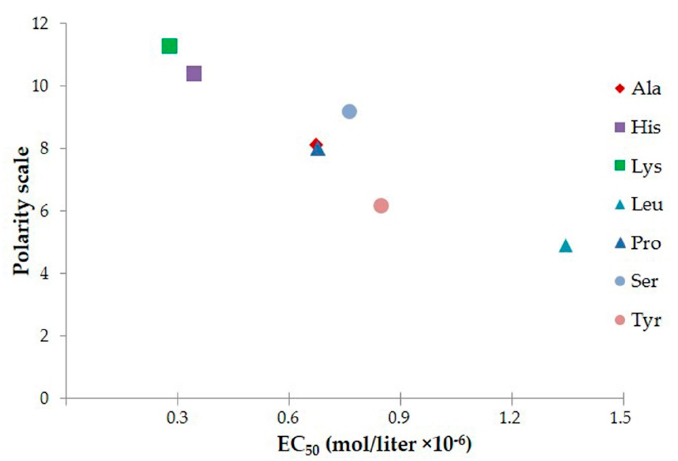
Figure 14. Correlation between polarity of the first residue and peptide EC 50 .